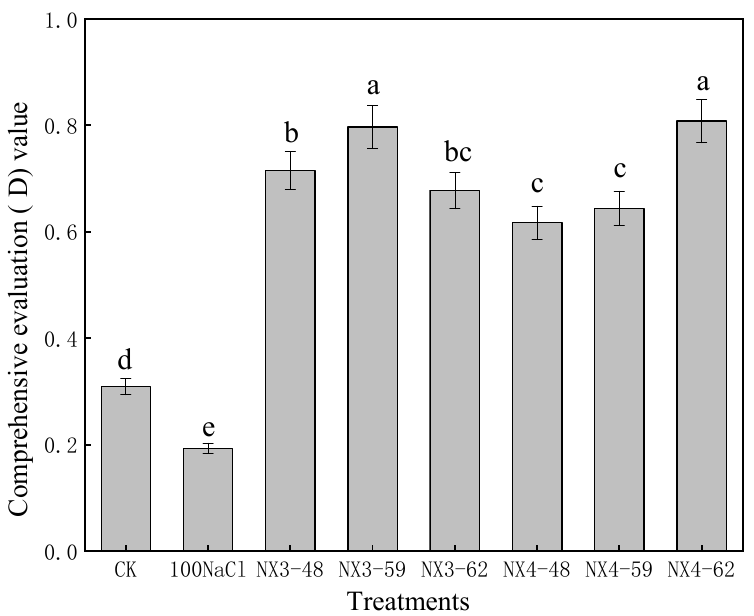
Figure 7. Comprehensive evaluation D value calculated by PCA analysis and membership function method for different inoculation treatments. Different letters indicate a significant difference between treatments at p < 0.05.